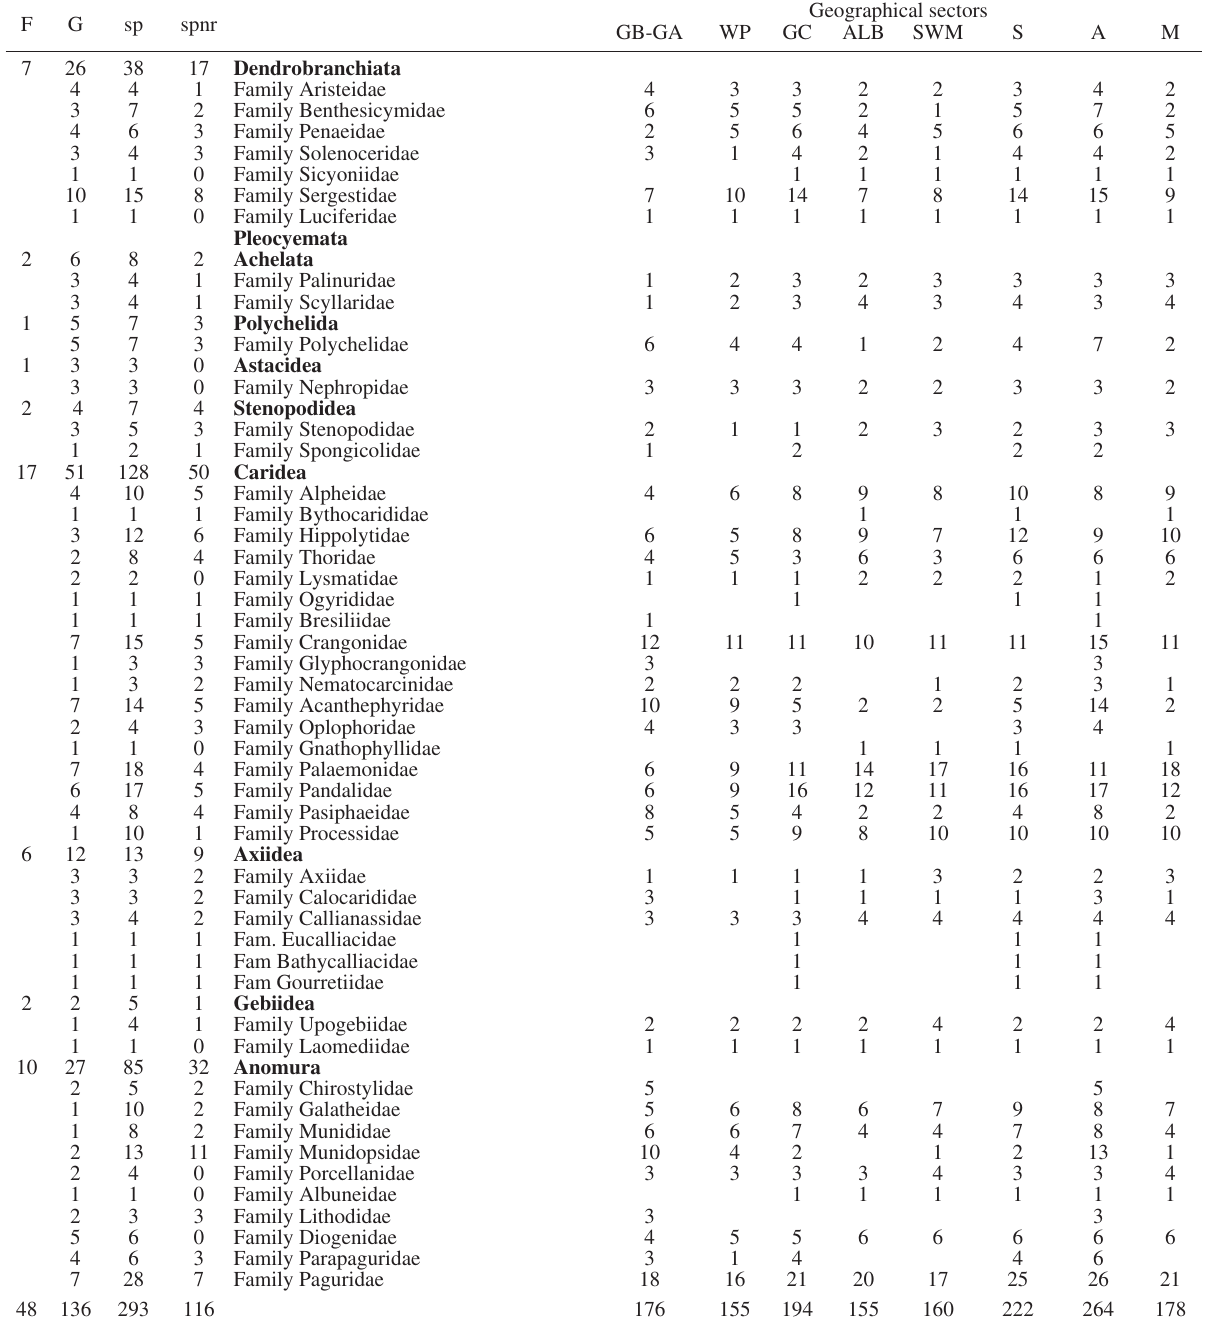
Table 2. – Number of marine decapod, families (F), genera (G), species, total (sp) and new registers after Zariquiey Álvarez (1968) (spnr) (ex- cluded crabs and freshwater species) ordered by families and geographical sectors. GB-GA, Gulf of Biscay and Galicia; WP, western Portugal; GC, Gulf of Cádiz or southwestern Iberian Peninsula; ALB, Alboran Sea; SWM, Spanish western Mediterranean; S, southern Iberian waters (GC+ALB); A, Atlantic Iberian waters (GB-GA+WP+GC); M, Mediterranean Spanish waters